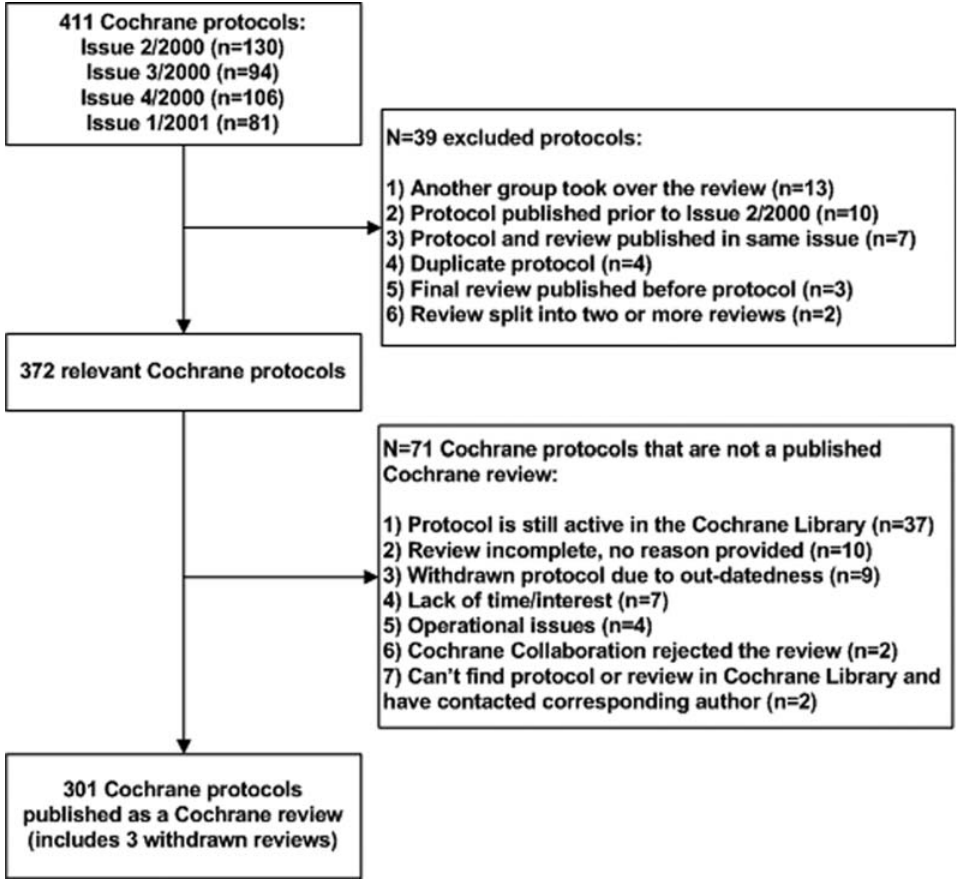
Figure 1. Study flow. The cohort included a total of 411 Cochrane protocols and 379 (90.5%) remained after excluding 39. Of these protocols, 19.1% (71/372) were never published as full Cochrane reviews while 80.9% (301/372) were published in full.